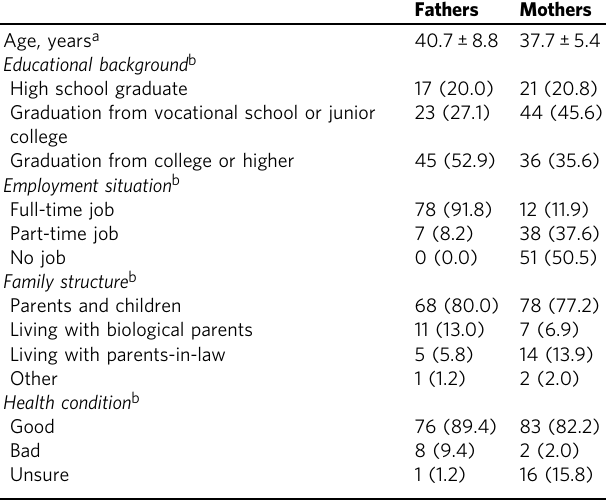
Table 2 Attributes of the respondents.